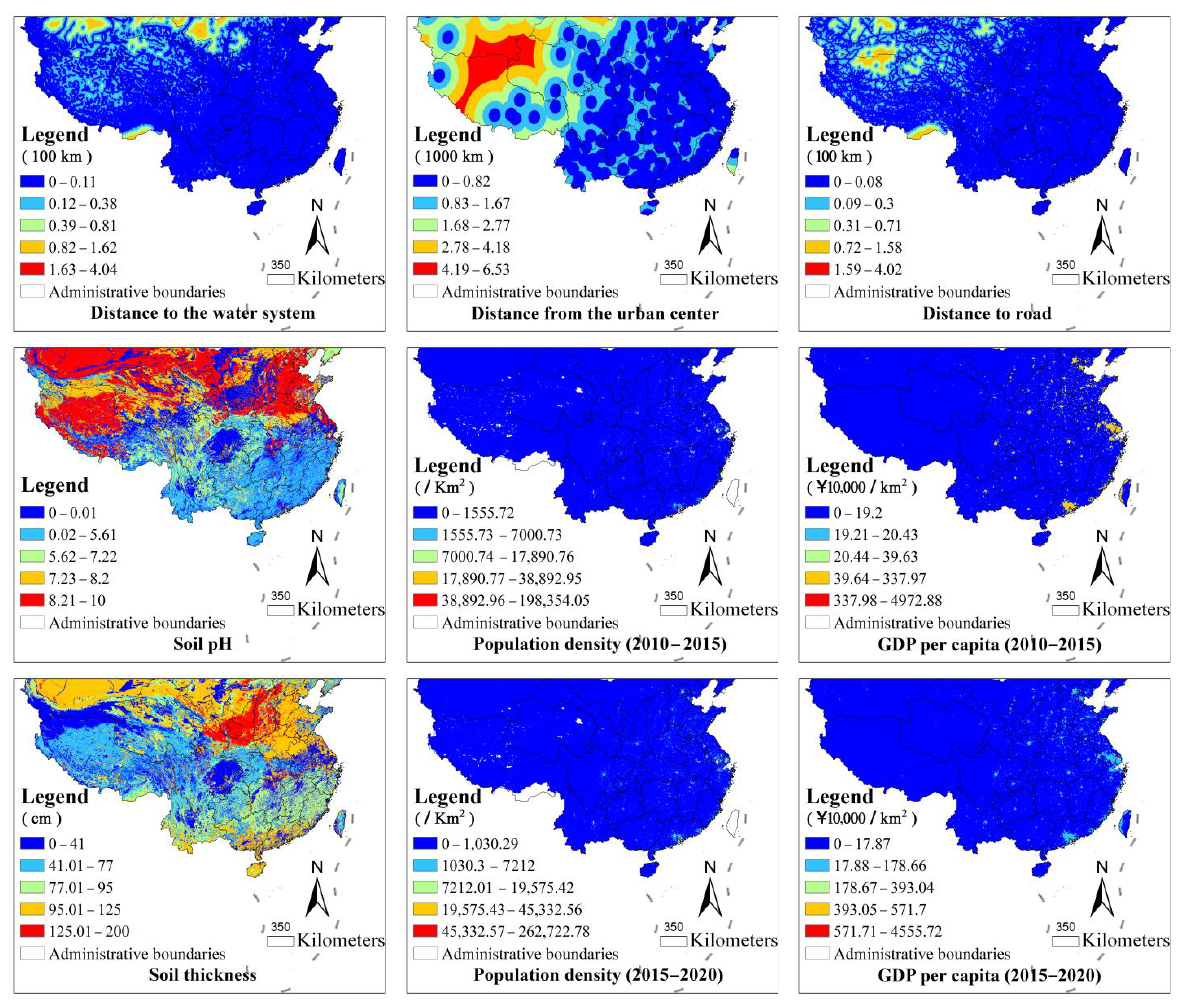
Figure 7. Spatial distribution of driving factors (2).